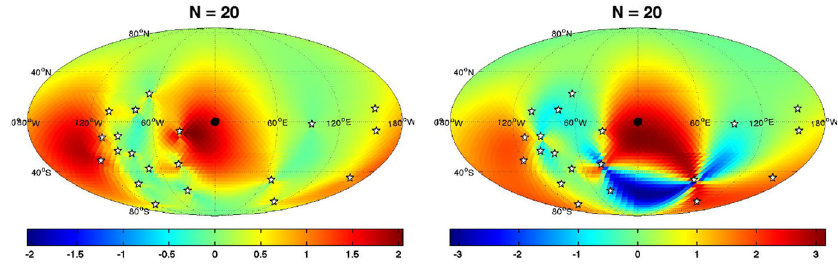
Fig. 48 Point spread functions for the array of N = 20 pulsars listed in Table 6 for both equal-noise weighting ( left panel ) and actual-noise weighting ( right panel ), using the timing noise values in the second column of the Table. The timing noise values were rescaled by an overall factor so that the maps for the two different weighting schemes could be meaningfully compared with one another. The point source is located at the center of the maps, indicated by a black dot